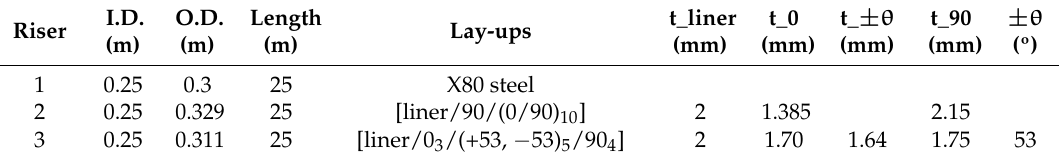
Figure 3. Cross ‐ section for ( a ) steel riser joint and ( b ) composite riser joint. Figure 3. Cross-section for ( a ) steel riser joint and ( b ) composite riser joint. Table 4. Geometries of Table 4. Geometries of risers.